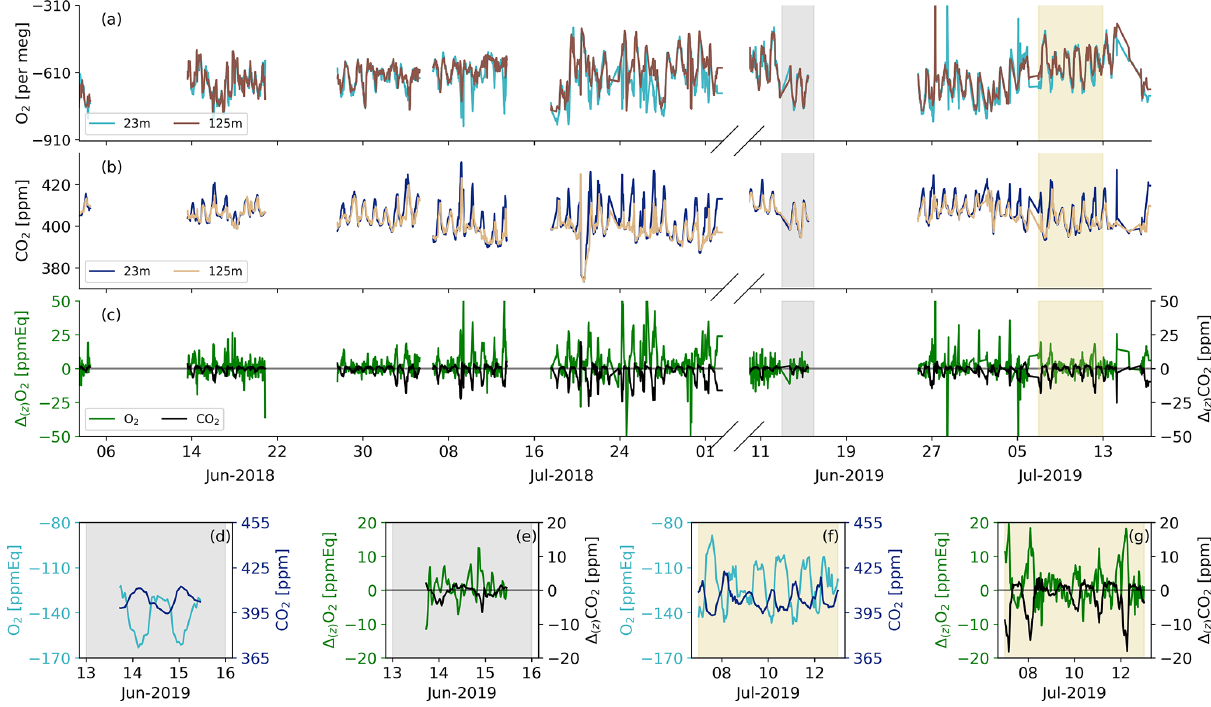
Figure 3. The half-hourly average O 2 (a) and CO 2 (b) concentrations at Hyytiälä for spring/summer of 2018 and 2019 for the 125 and 23m height levels, together with the vertical gradient ( (cid:49) ( z ) ) between these two heights (c) for both O 2 and CO 2 . The shaded areas indicate the dates that were selected for the aggregate representative day (7 through 12 July 2019: yellow) and the second representative day to test the O 2 method (13 through 15 June 2019: grey). The selected days for the aggregate representative days are shown in more detail for the 23m measurements for the gradients during 13 through 15 June (d) and (e) and during 7 through 12 July (f) and (g) for both O 2 and CO 2